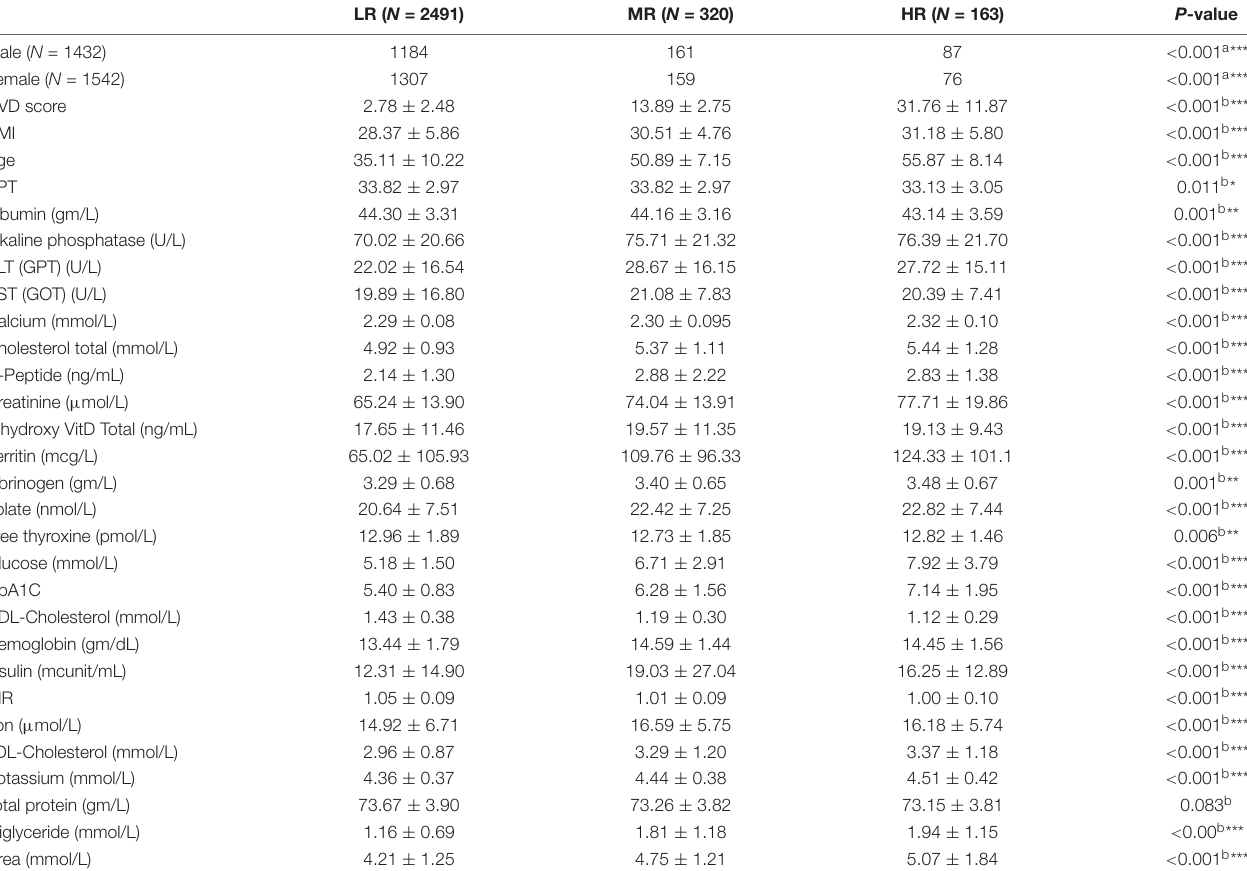
TABLE 1 | Clinical parameters of the study